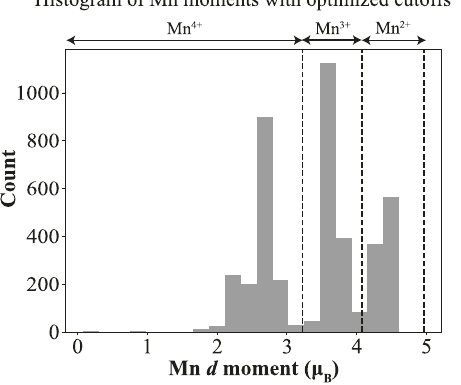
Fig. 1 All Mn moments in 775 DFT-SCAN structures with Bayesian-optimized moments (dashed line). The optimized cutoffs results in 642 out of 775 charge-balanced